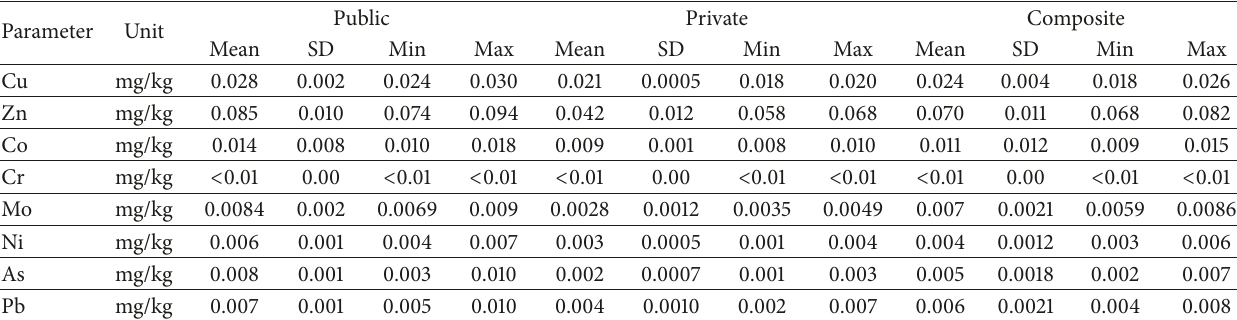
Table 4: Summary results for heavy metals composition of the faecal